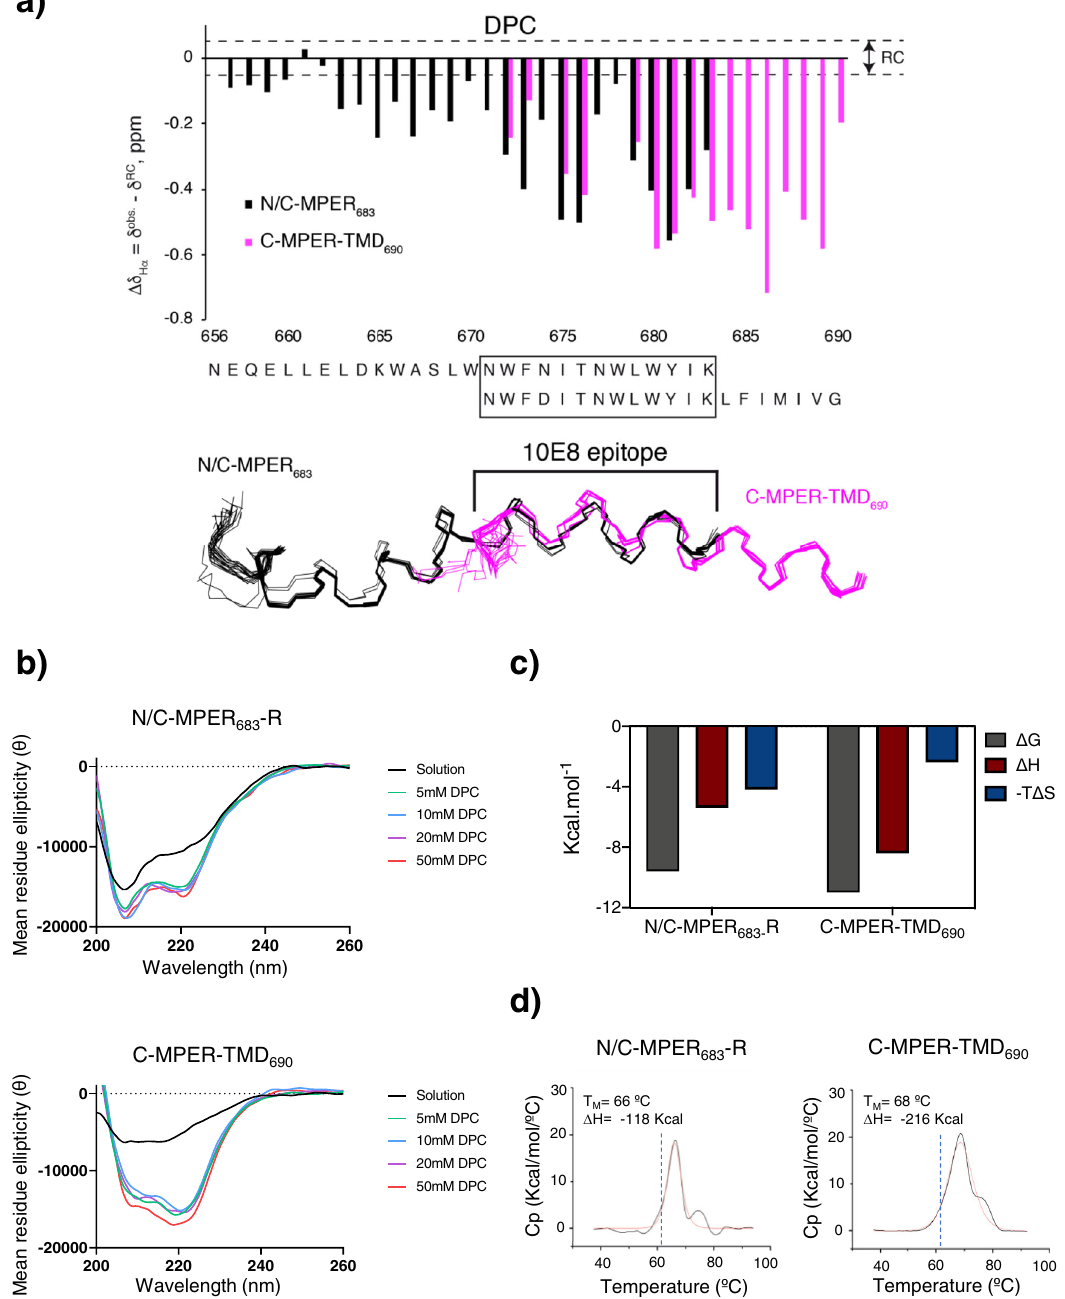
Fig. 2 Binding energetics of Fab 10E8 to helical C-MPER epitope in presence of DPC micelles. a Comparison of NMR structures of N/C-MPER 683 19 and C- MPER-TMD 690 in presence of DPC micelles. Top: H α conformational shifts ( Δδ H α , ppm) observed for both peptides in 20mM DPC micelles, pH 7.0. Dashed lines indicate the random coil (RC) range. Bottom: superposition of the 3D structural models supporting the adoption of similar conformations by the 10E8 epitope sequence in both peptides. b CD spectra obtained for N/C-MPER 683 − R and C-MPER-TMD 690 at 25°C in the presence of increasing concentrations of DPC. c Thermodynamic signatures of the binding of Fab 10E8 and peptides N/C-MPER 683 -R or C-MPER-TMD 690 determined by ITC in the presence of 5mM DPC. d StabilityofFab with peptidebound.DSCscans of 10E8 in the presenceofN/C-MPER 683 -R or C-MPER-TMD 690 werecollected between 35and95ºC. Thevalues of the melting temperature ( T M ) of the main transition and unfolding enthalpy ( Δ H ) are shown. Black and red lines represent raw data and fi tting curves, respectively. The dotted vertical blue lines indicatethe T M value of the apo form of 10E8. Thermodynamic parameters shownfor peptideC-MPER-TMD 690 ( c , d ) as previously reported in our previous study 29 . These values were obtained under the same experimental conditions as the ones used in the current for N/C-MPER 683 -R ( Δ H = − 5.4 ± 0.1 kcal mol − 1 ), suggesting MPER 683 -R ( K D = 10 ± 1.6 nM and 93 ± 13 nM, respectively) (Fig. 2c and Supplementary Fig. 3). Moreover, the binding stronger and more durable interactions of the antibody with the signature of C-MPER-TMD 690 indicated a signi fi cantly more peptide derived from the C-terminal subregion of MPER. Pre- favorable binding enthalpy ( Δ H = − 8.4 ± 0.1 kcal mol − 1 ) than that dictably, the entropic component of the interaction contributed less